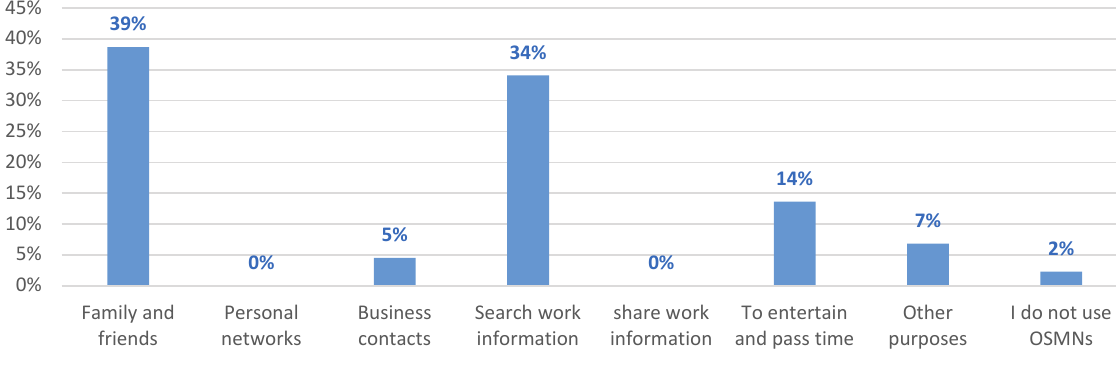
Fig. 5. The purposes of using the